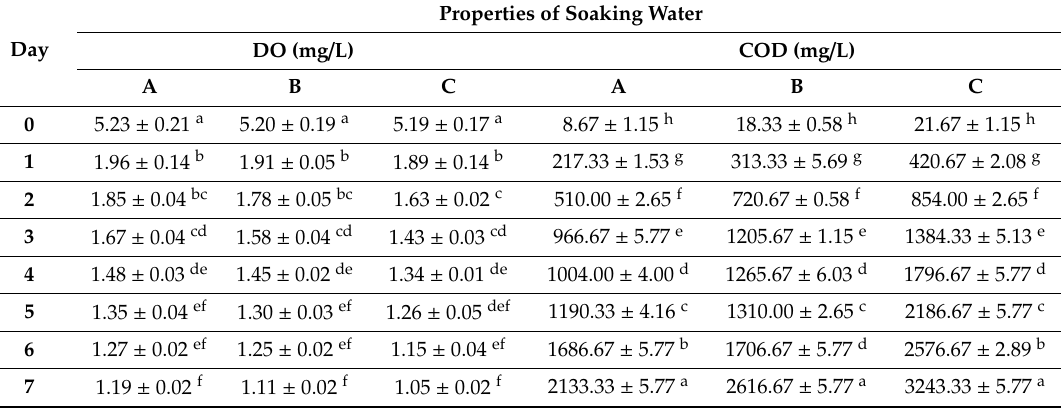
Table 3. Mean values for dissolved oxygen (DO) and COD of soaking water during 7 days of soaking